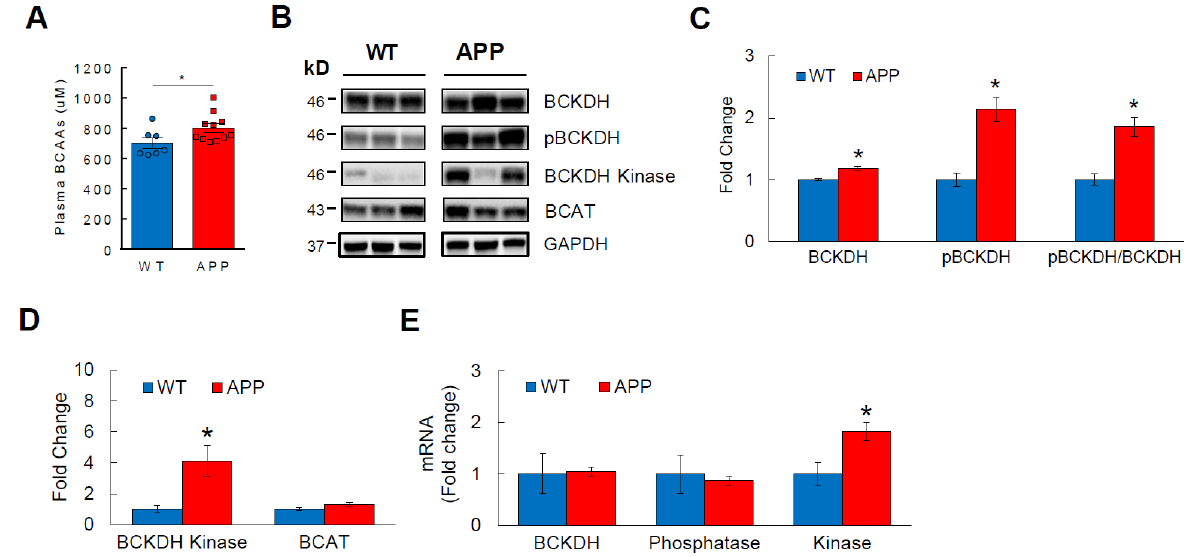
Figure 2. BCAA metabolism is impaired in transgenic APP Swe mice. 8-month-old WT or APP Swe AD mice were sacrificed after overnight fasting. ( A ) Fasting plasma BCAA levels measured by spectrophotometric assay. ( B ) Western blots showing liver protein abundance of BCKDH, the rate-limiting enzyme in BCAA breakdown; phosphorylated, inactive state of BCKDH (pBCKDH); BCKDH kinase, an enzyme that phosphorylates BCKDH; and BCAT, an enzyme involved in the reversible first step in BCAA degradation. ( C ) Analysis of BCKDH, pBCKDH, and the inactivity index (pBCKDH/BCKDH ratio). ( D ) Analysis of BCKDH kinase and BCAT in liver. ( E ) mRNA expression analysis of BCKDH, BCKDH phosphatase, and BCKDH kinase via RT-qPCR in liver normalized to GAPDH. n = 7 – 13 males/group; Analyzed by student’s t -test. * p < 0.05. Phosphatase — BCKDH phosphatase; Kinase — BCKDH kinase.